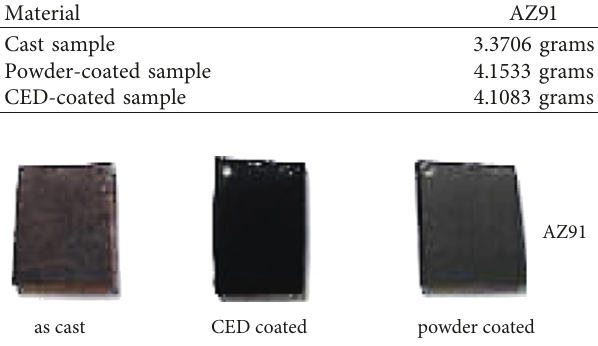
Figure 12: Samples before immersion